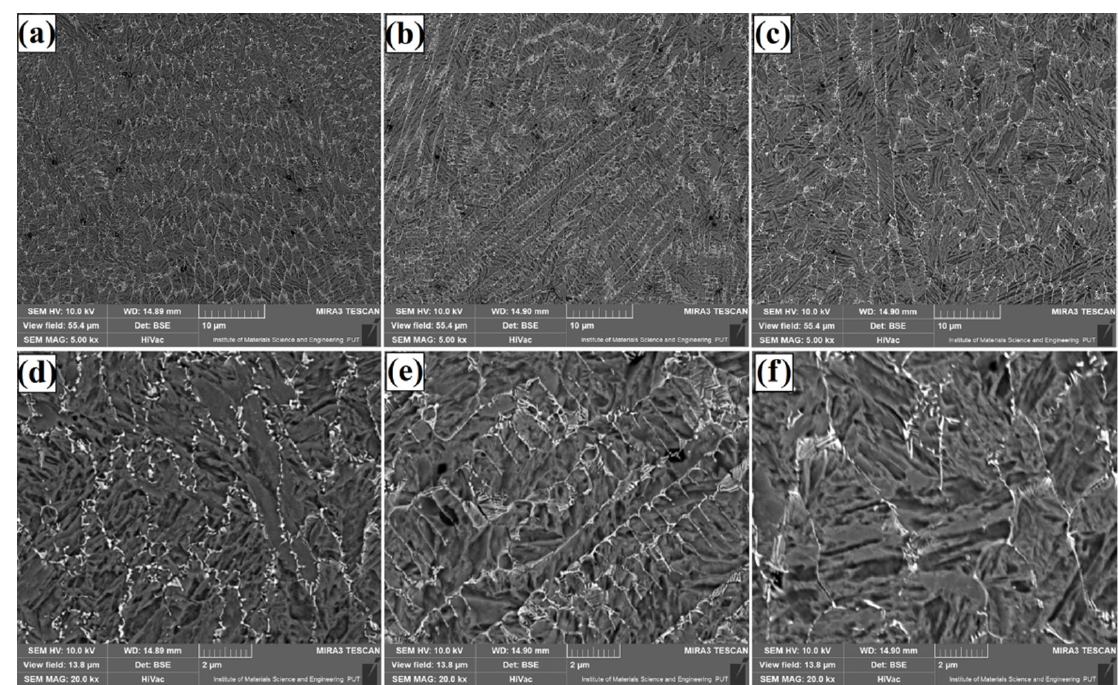
Figure 9. Near-substrate area of the Fe/TaC coatings produced on tool steel using 30 µm thick pre-coat and laser beam power of 500 W ( a , d ), 800 W ( b , e ), 1100 W ( c , f ).